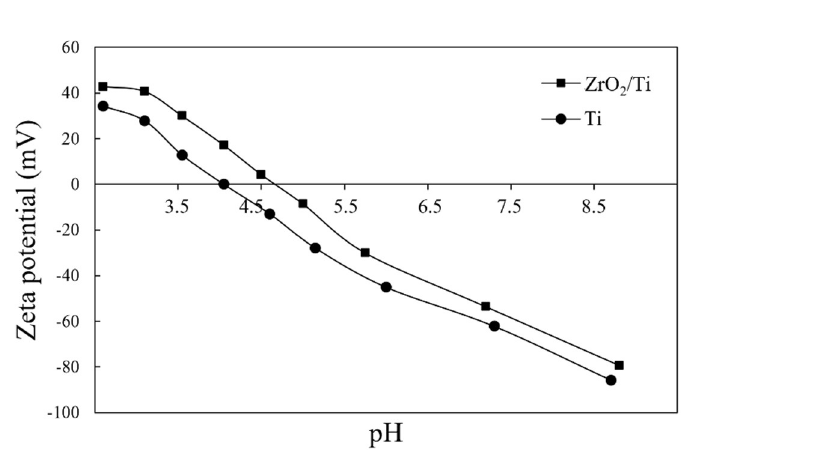
Figure 9. pH-dependent curves of the apparent zeta potentials of Ti and ZrO 2 /Ti at any pH level. Table 2. Apparent zeta potentials at a pH level of 5.6, and the isoelectric points of the Ti and ZrO 2 /Ti specimens.